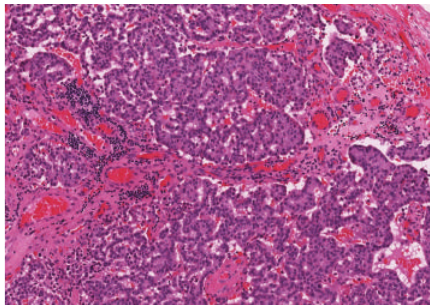
Figure 2: Hematoxylin and eosin stain of tissue removed from left nasopharynx at 20x demonstrating nest of tumor infiltrating soft tissues.